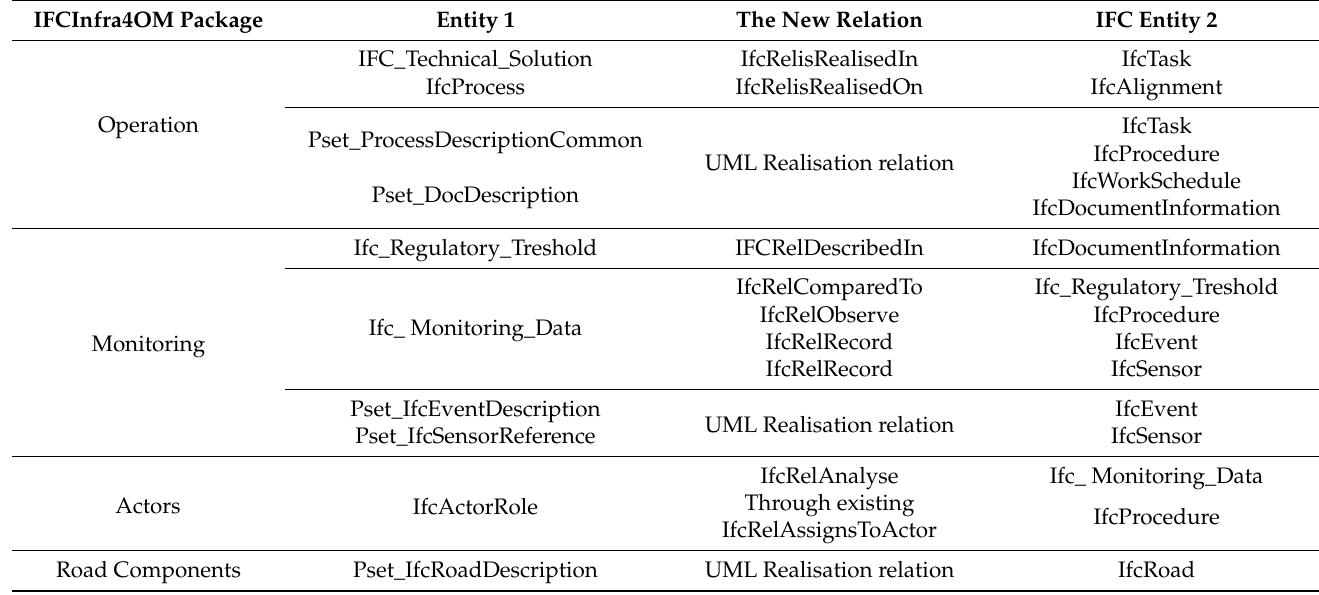
Table 7. IFC extension by IFCInfra4OM ontology mechanisms: relation